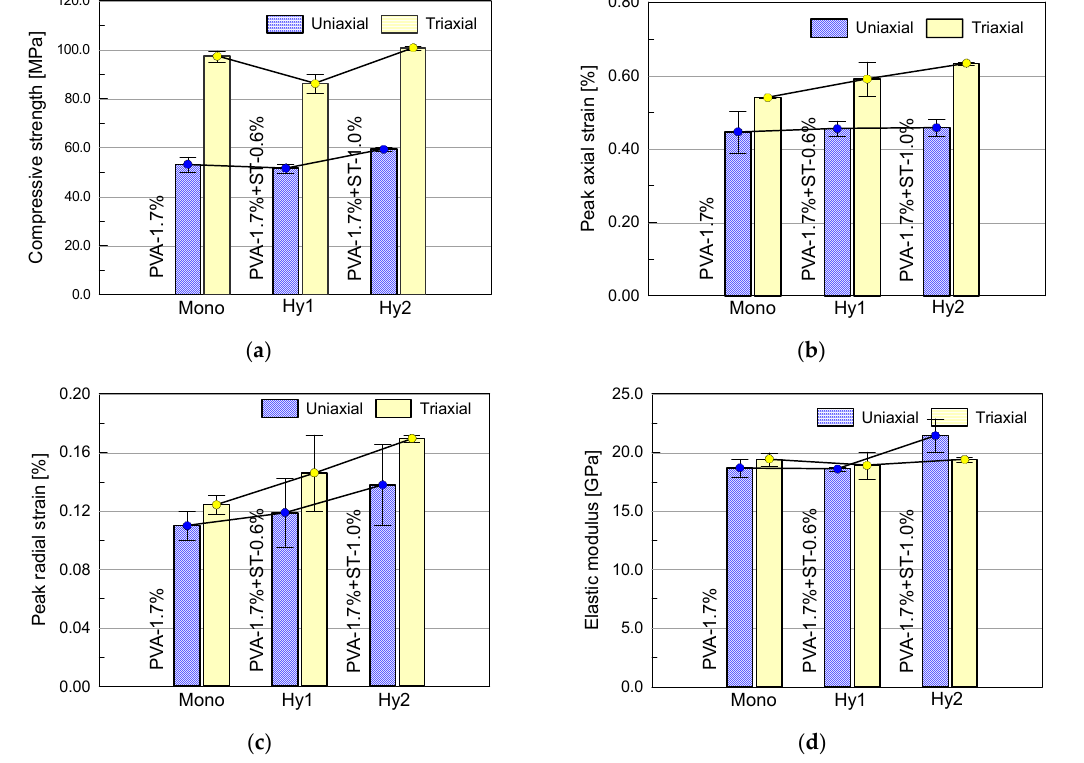
Figure 5. Effect of additional steel fiber content on ( a ) compressive strength, ( b ) peak axial strain, ( c ) peak radial strain and ( d ) elastic modulus of ECC under both uniaxial and triaxial compression.